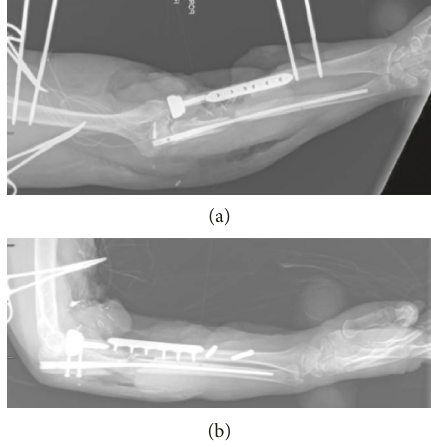
Figure 4: AP and lateral X-rays of the patient’s forearm on POD 75. The ulnar has an IMN nail, and the radius has an open reduction internal fixation of the fibular free graft demonstrating good